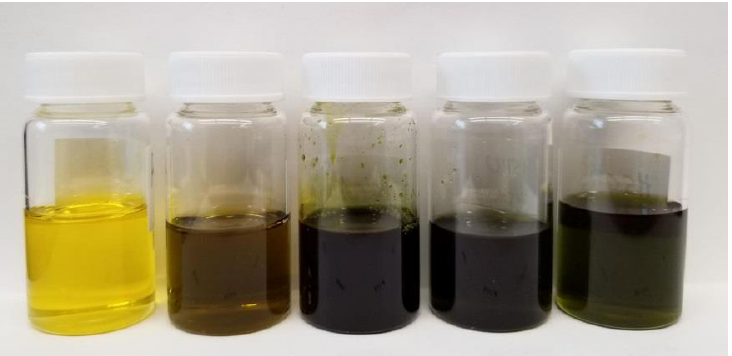
Figure 2. Hexane extract (oil), left to right — hemp hearts, whole seeds, hemp cake, hemp hulls and cold-pressed oil.